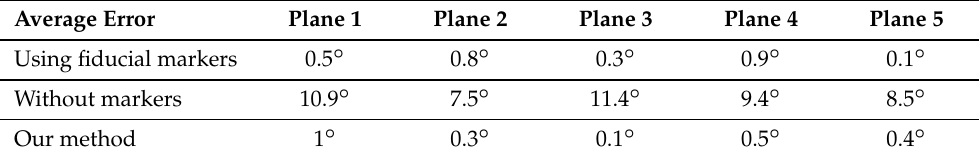
Table 2. Mean error of experiments regarding the plane inclination on Z-axis.